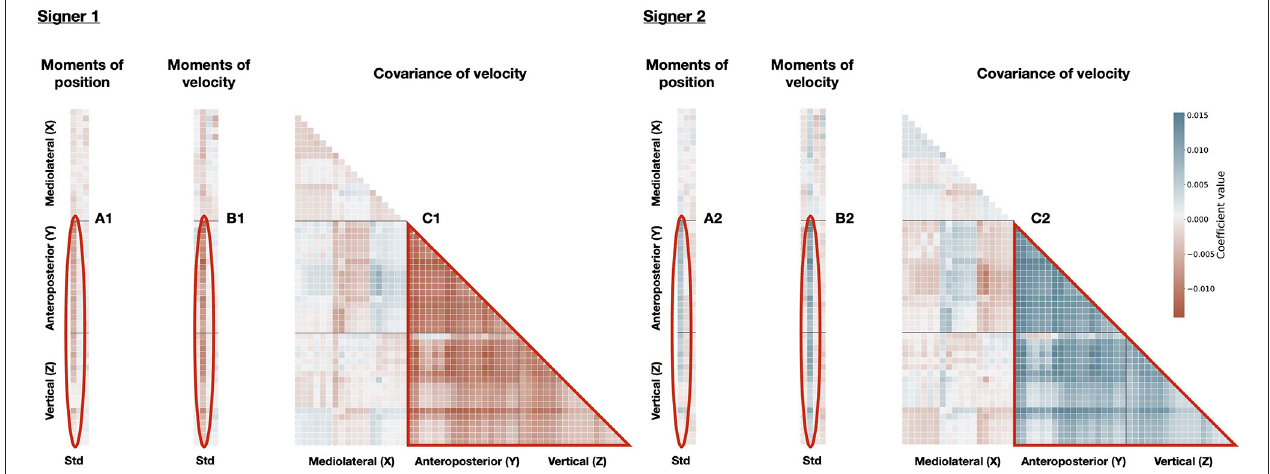
FIGURE 7 | Classifier weights of PC1 for Signer 1 and Signer 2. Similar to Figure 6 for Signer 1 (left) and Signer 2 (right): moments (columns: std, skew, kurtosis) of position for all markers (rows), moments (columns: mean, std, skew, kurtosis) of velocity for all markers (rows), the covariance of velocity between markers (rows and columns). Markers are sorted from 1 to 19 as presented in the Methods along X, Y, and Z axes. Coefficients correspond to the logistic regression weights optimized for each signer. Blue represents positive weight values, while red represents negative ones. The three patterns of importance are highlighted: Std of position (A1) and velocity (B1) of all body markers for Signer 1; Std of position (A2) and velocity (B2) of all body markers for Signer 2; (C1) Covariance of velocity between all body markers along Y and Z axes for Signer 1; (C2) Covariance of velocity between all body markers along Y and Z axes for Signer